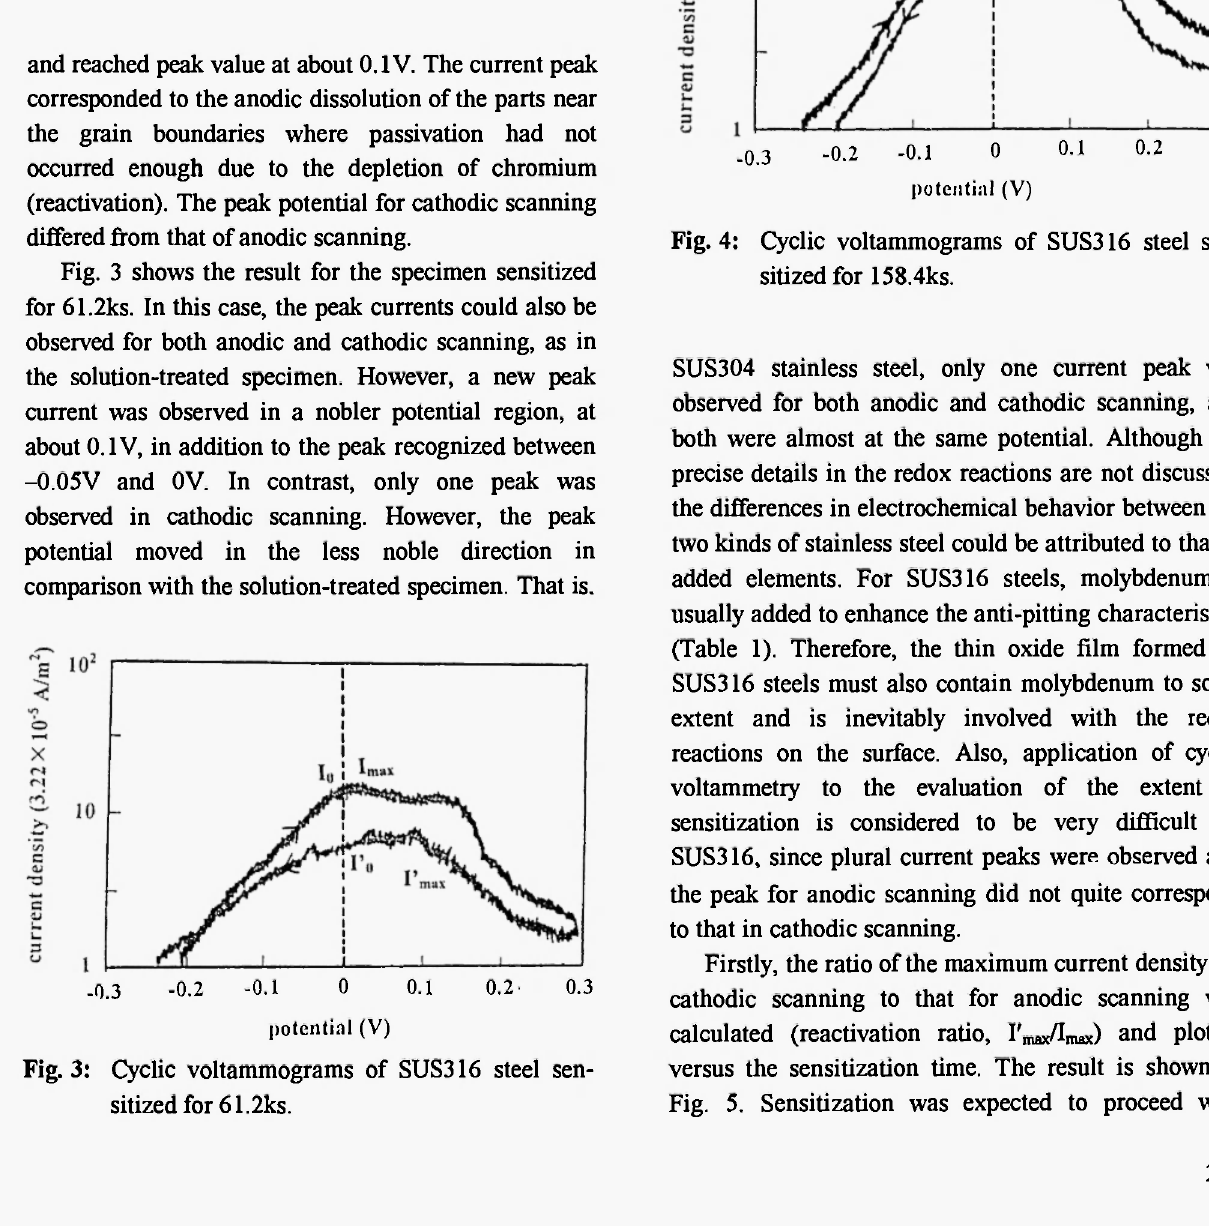
Fig. 2: Cyclic voltammograms of solution treated SUS316 steel.